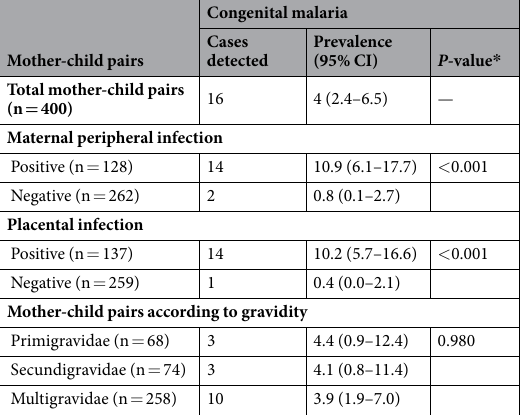
Table 2. Prevalence of congenital malaria as detected by qPCR. * P value determined by Fisher’s exact test. CI, confidence interval.